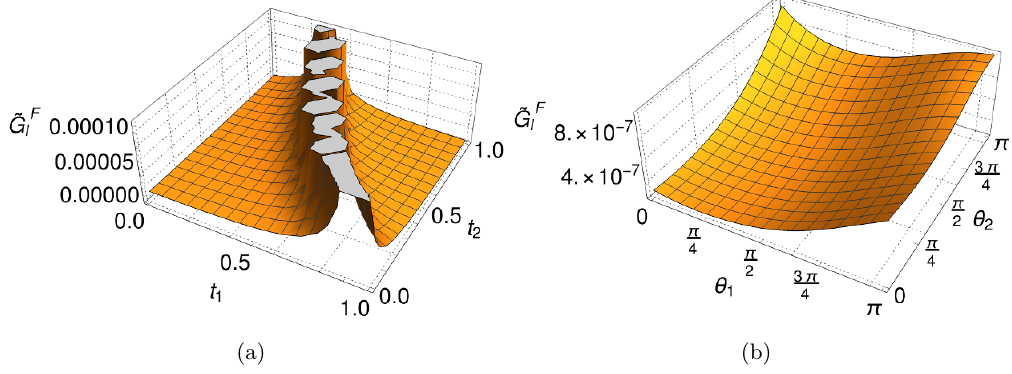
Figure 6 . A slice of the I10 2 integrand at O ( (cid:15) 0 ) (a) without a complex mapping and (b) with a complex mapping and the contour orientation determined via TayInt , setting (cid:18) 0 = (cid:25) m 2 = m 1 p and m 1 = 173 GeV. In (a) no reorientation of contours is possible as the surface is 2 constrained to the real